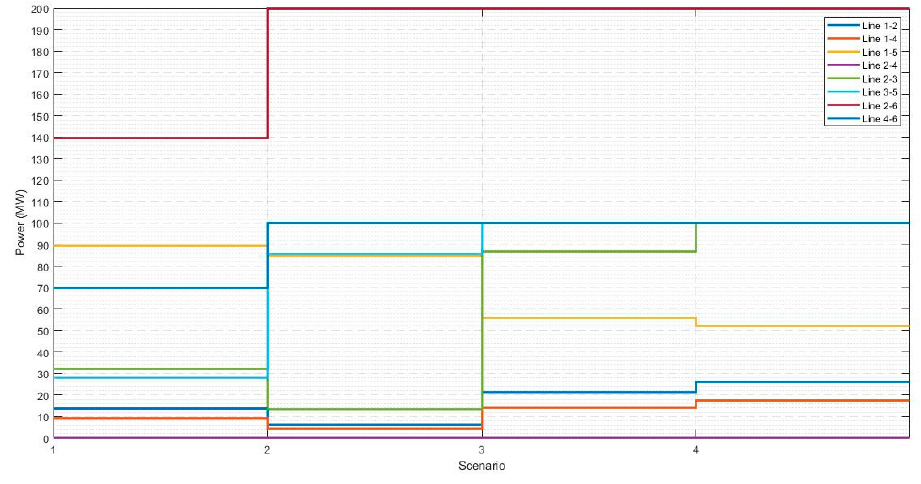
Figure 3. Power flows through the lines, whit expansion.